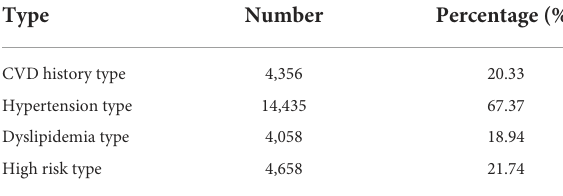
TABLE 2 Classification of high-risk groups for